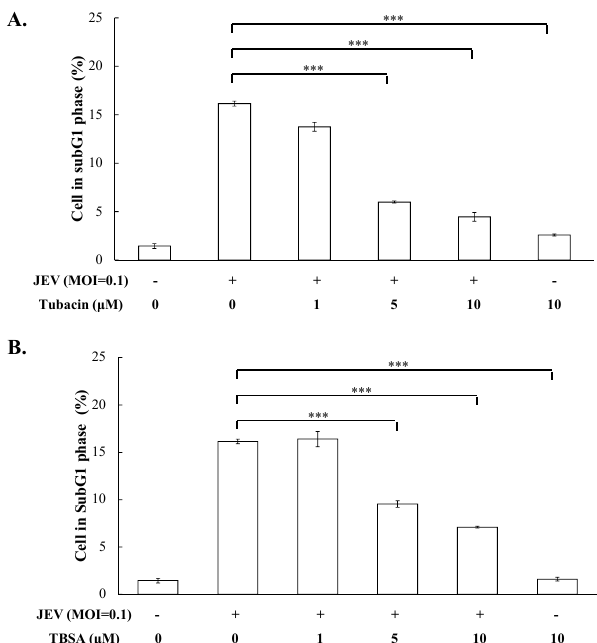
Figure 2. Inhibition of JEV-induced apoptosis by tubacin and TBSA. Cells were infected with JEV (MOI of 0.1), and immediately treated with tubacin ( A ) and TBSA ( B ). After 36 h incubation, cells were harvested, stained by PI dye, and then analyzed using flow cytometry. The percentage of sub-G1 phase in infected cells was presented. *** p value < 0.001 compared with mock-treated infected cells.